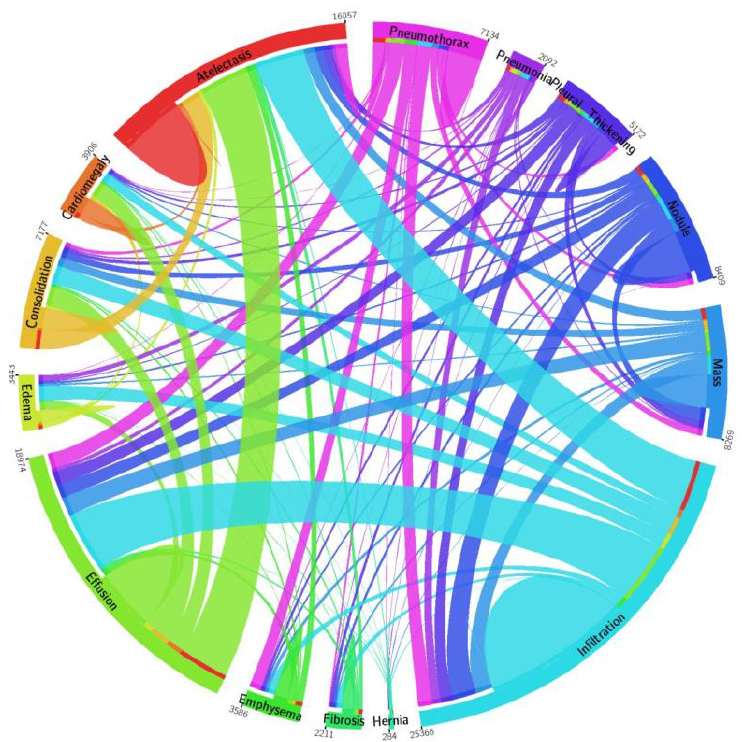
Figure 2. A visual description of the distribution of images from the NIH Chest X-ray repository [38]